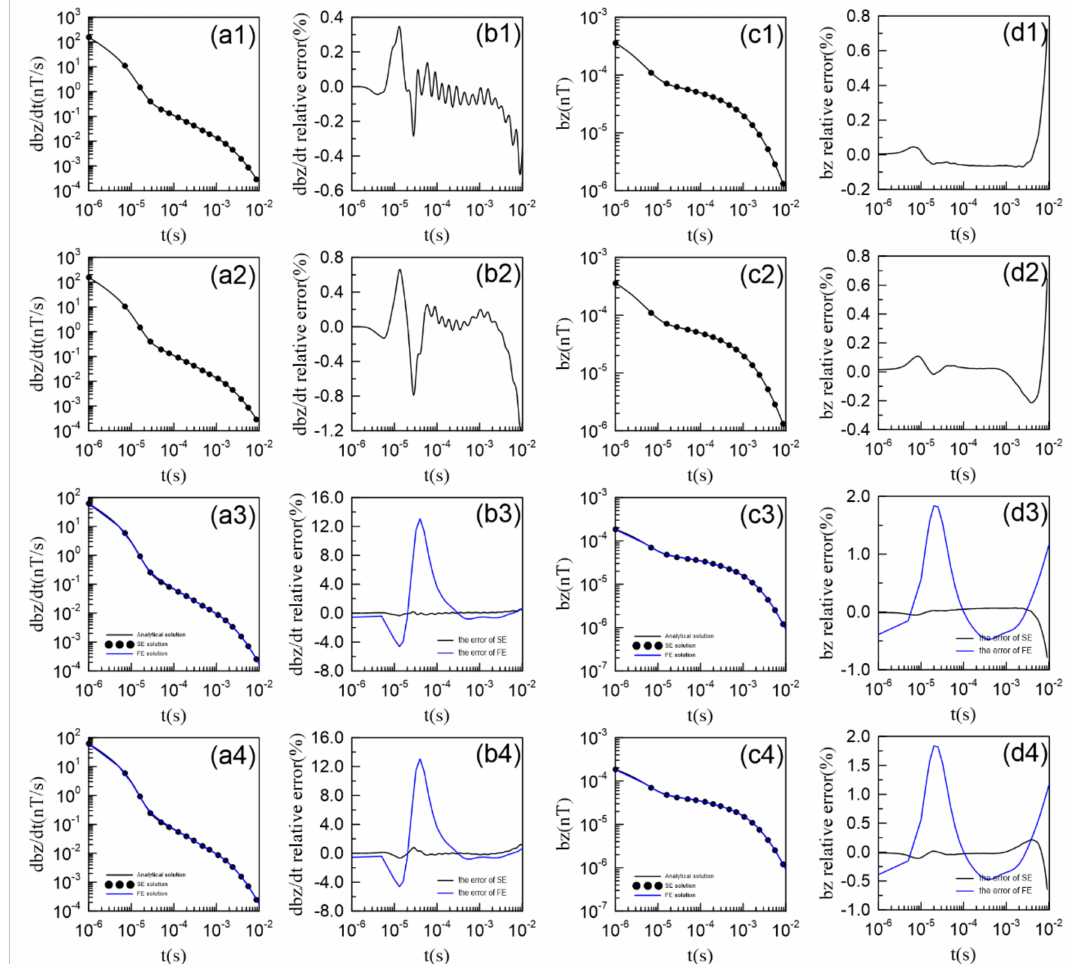
Figure 2. dbz/dt and bz responses and relative errors against the semi-analytical solutions for the 3-layer model in Figure 1. ( a1 )–( d1 ) Scheme 1: 40 m × 40 m × 20 m mesh combined with the third order of interpolation basis functions; ( a2 )–( d2 ) Scheme 2: 60 m × 60 m × 20 m mesh combined with the fourth order of interpolation basis functions; ( a3 )–( d3 ) Comparison of the finite-element solutions based on structured grids with the spectral element solutions via Scheme 1; ( a4 )–( d4 ) Comparison of the finite-element solutions with the spectral element solutions via Scheme 2. The central grid size for the finite-element method is 2 m × 2 m × 2